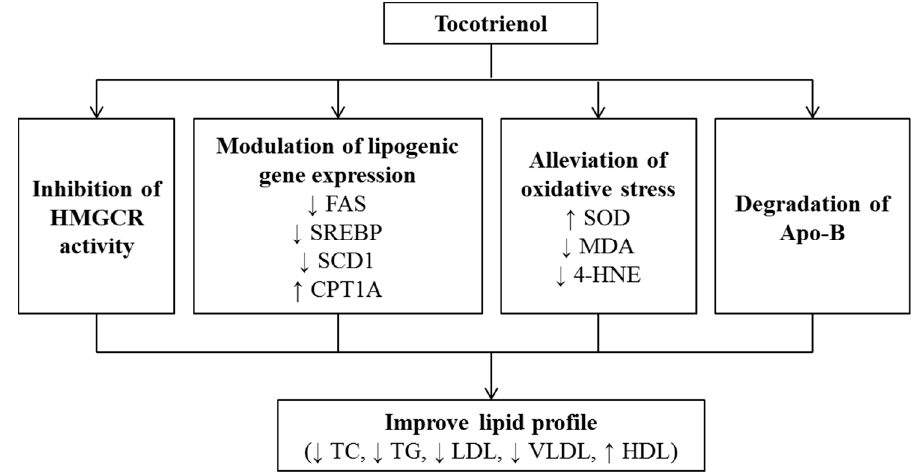
Figure 1. Effects of T3 on lipid metabolism. Figure 1. E ff ects of T3 on lipid Table 1. Effects of T3 on lipid metabolism in vitro.